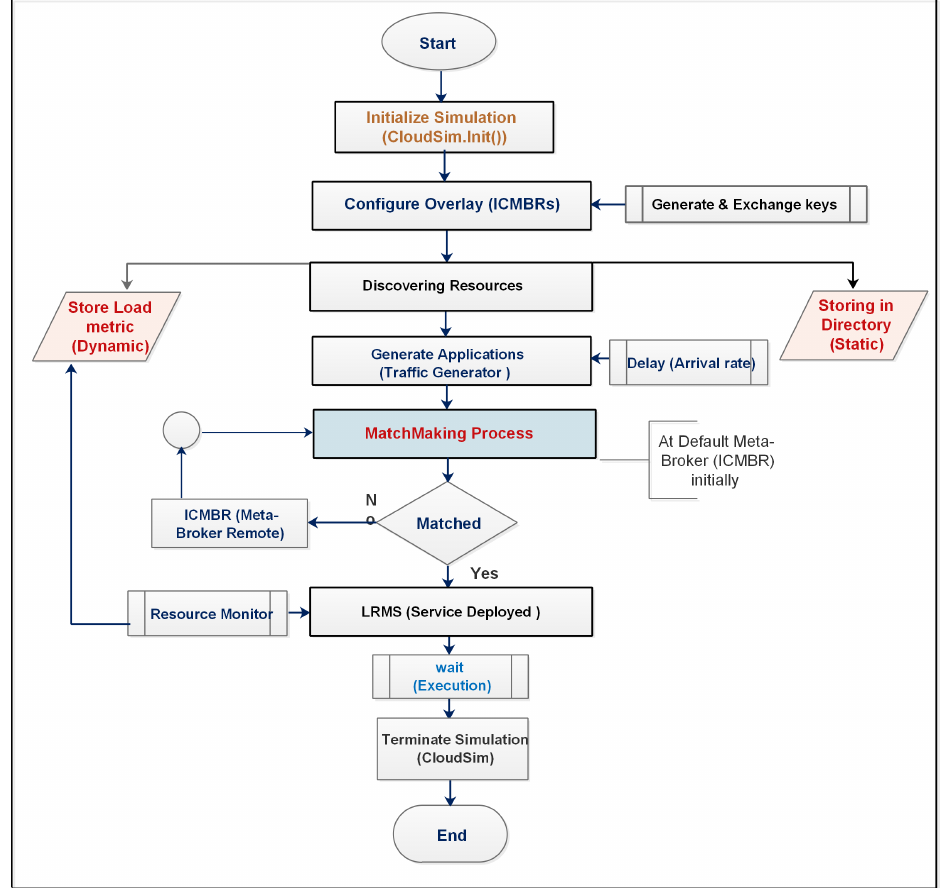
Figure 9. Simulation Flow of Proposed